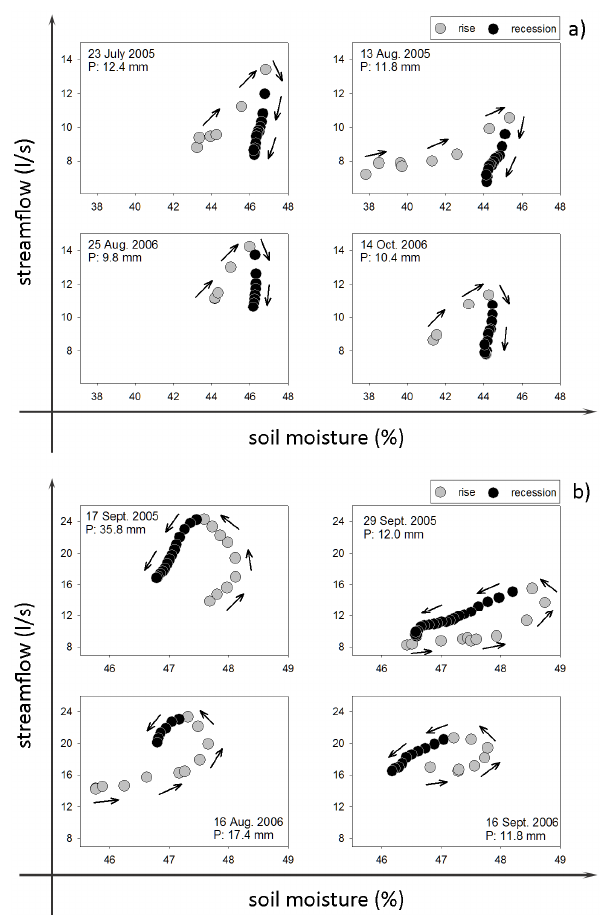
Figure 8. Hysteretic behaviour in the relationship between average soil moisture at 0-30 cm and 676 streamflow for various events with dry (a) and wet (b) antecedent conditions. 677 Fig. 8. Hysteretic behaviour in the relationship between average soil moisture at 0–30cm and streamflow for various events with dry (a) and wet (b) antecedent conditions. P : event cumulative precipitation.